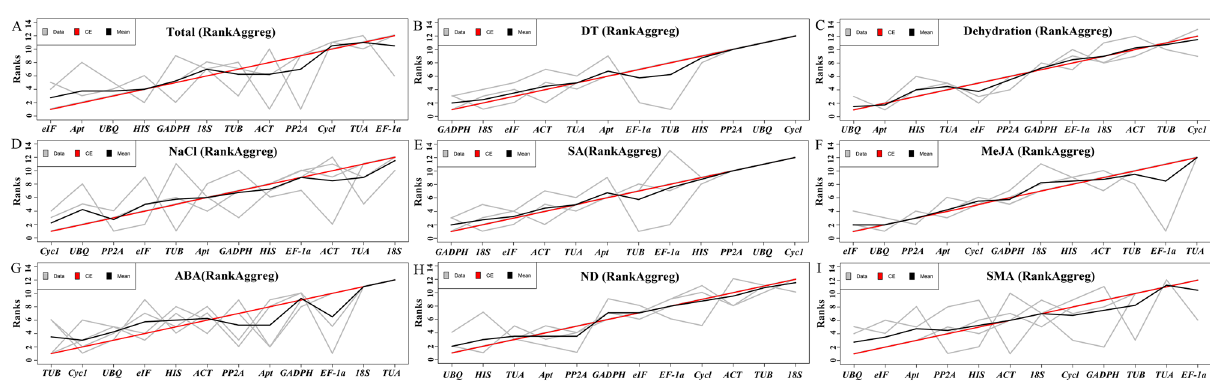
Figure 6. The comprehensive ranking list of 12 genes by RankAggreg. The gray lines show the ranking lists of ∆Ct, NormFinder, BestKeeper and geNorm. The black line indicates the mean rank position of each gene. The red line indicates the result of RankAggreg with the Monte Carlo algorithm and Spearman footrule distances. ( A ) Total: the set of total samples. ( B ) DT: the set with the samples of different tissues. ( C ) Dehydration treatment samples. ( D ) NaCl treatment samples. ( E ) SA treatment samples. ( F ) MeJA treatment samples. ( G ) ABA treatment samples. ( H ) ND: the set with the samples of NaCl and dehydration treatments. ( I ) SMA: the set with the samples of SA, MeJA, and ABA